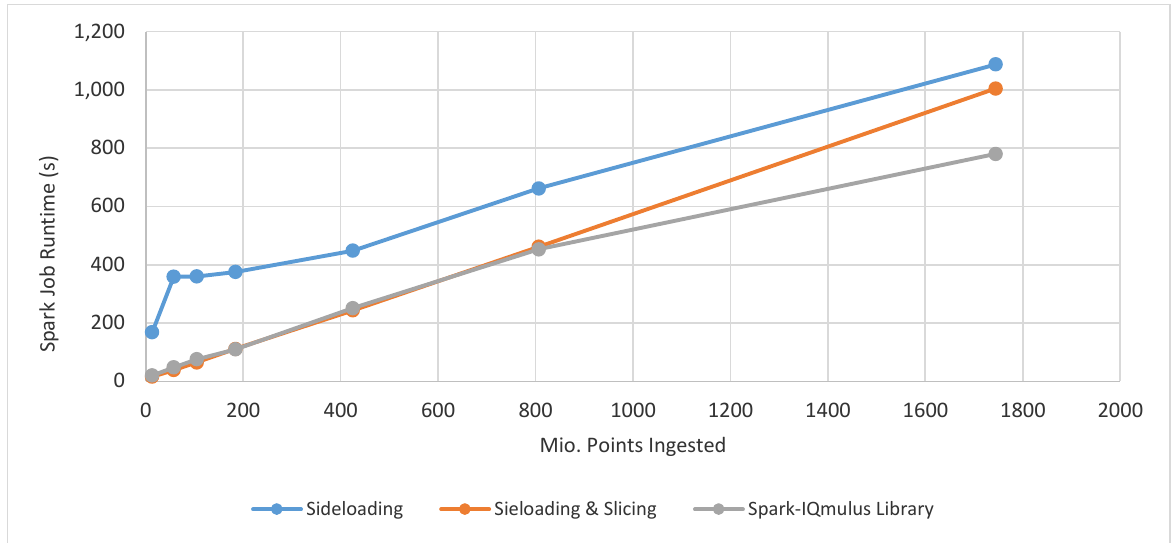
Figure 9: Runtime for sideloading over varying number of points from a medium sized point cloud data set.